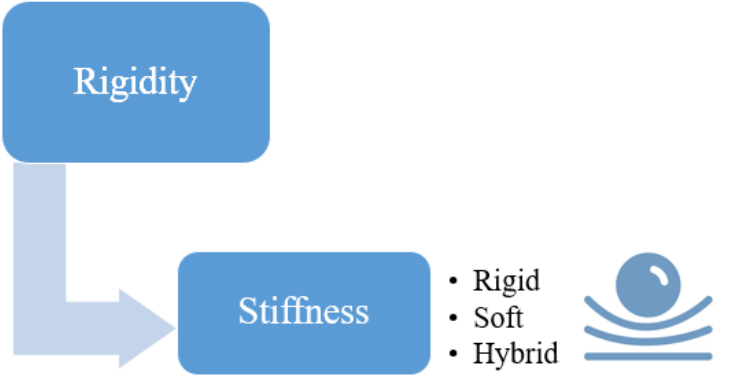
Figure 13. Rigidity requirements for wrist